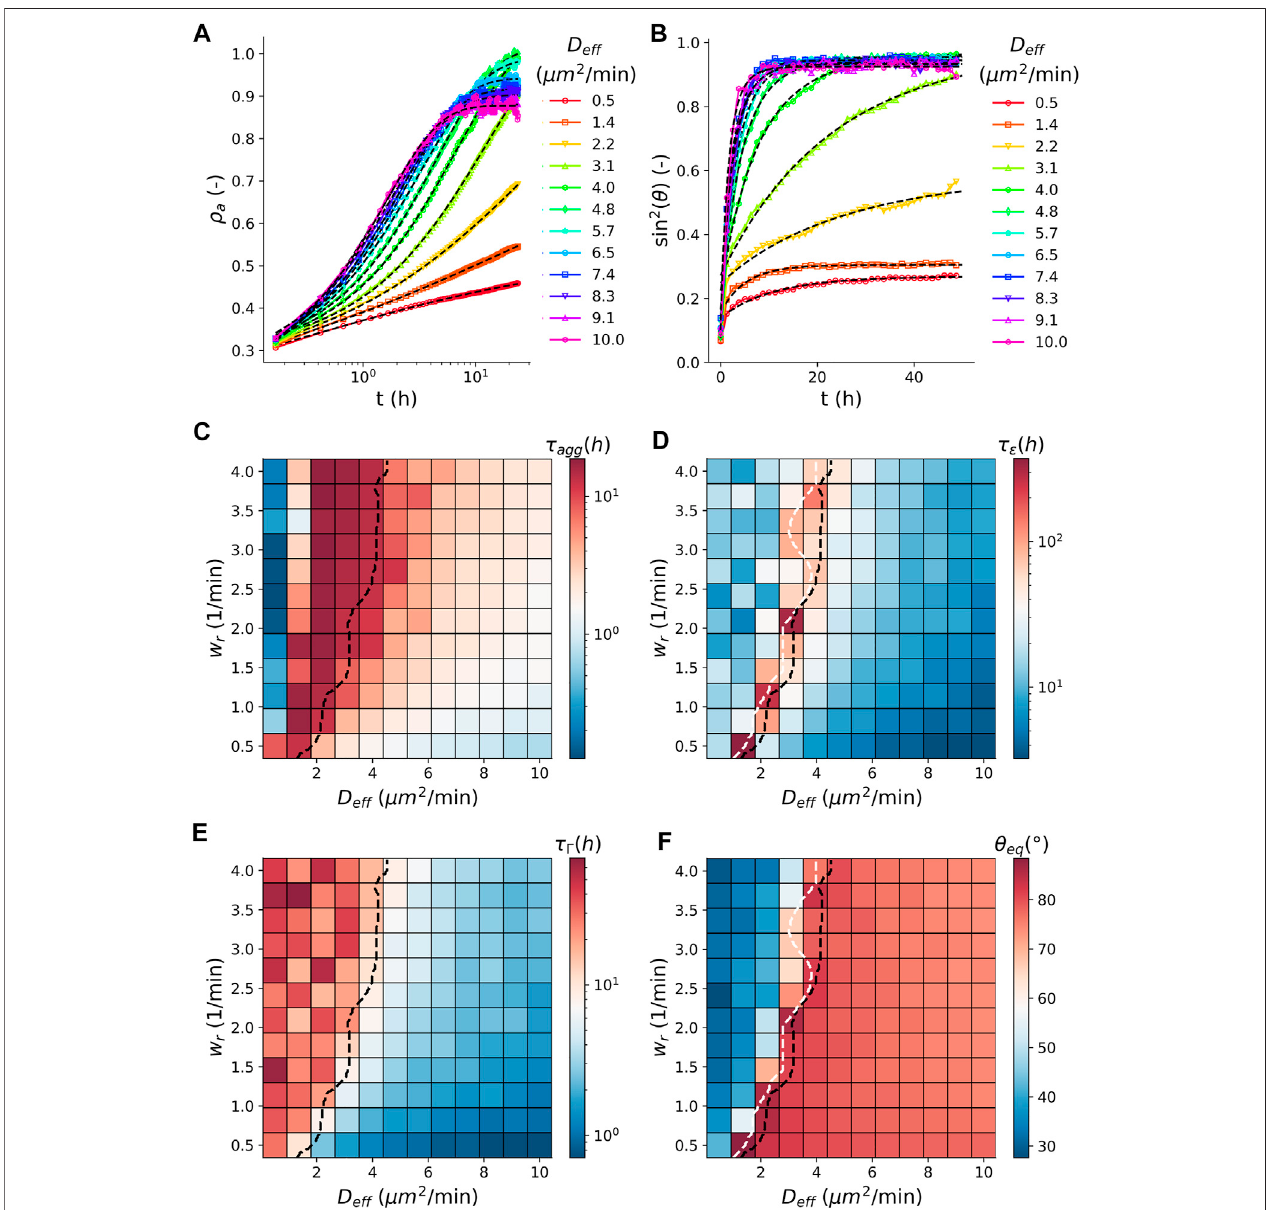
FIGURE3| Comparisonbetweenaggregationandfusion. (A) Timeevolutionoftheaverage( N (cid:1) 100)apparentdensity ρ a forvaryingactivity D eff atconstantlevelof cellrepulsion w r (cid:1) 2 . 09min − 1 .The fi tsoftheKWWlaw Eq.5 ,areshownasblackdashedlines. (B) Average( N (cid:1) 50)fusiondynamics,representedassin 2 ( θ ) ,forvarying cellactivity D eff atconstantlevelofcellrepulsion w r (cid:1) 2 . 09min − 1 .Basedonthefusiondynamicsequation Eqs.2 , 3 ,thesimulateddatais fi ttedintheformsin 2 ( θ ) .These fi tsareshownasblackdashedlines. (C) Estimatedvaluesof τ agg basedonKWWlaw Eq.5 duringaggregationforvaryingcellrepulsion w r andcellactivity D eff .The blackdashedlineshowstheseparationofarrestedversuscompletefusionbasedon θ eq .Asimilartrendbetweenthisblackdashedlineandthedivergencein τ agg canbe observed. (D – F) Estimated values of the visco-elastic time constant τ ε , the visco-capillary time constant τ Γ based on fi tting fusion dynamics in sin 2 ( θ ) using Eqs. 2 , 3 , andtheequilibriumangle θ eq calculatedusing Eq.4 .Theblackdashedlineshowstheseparationofarrestedversuscompletefusionbasedon θ eq .Thewhitedashedline representstheseparationbetweentworegionsoflow τ ε .Bothlinesareobtainedbyperformingawatershedsegmentationontheimagesof θ eq andlog ( θ ε ) ,respectively, and show a similar